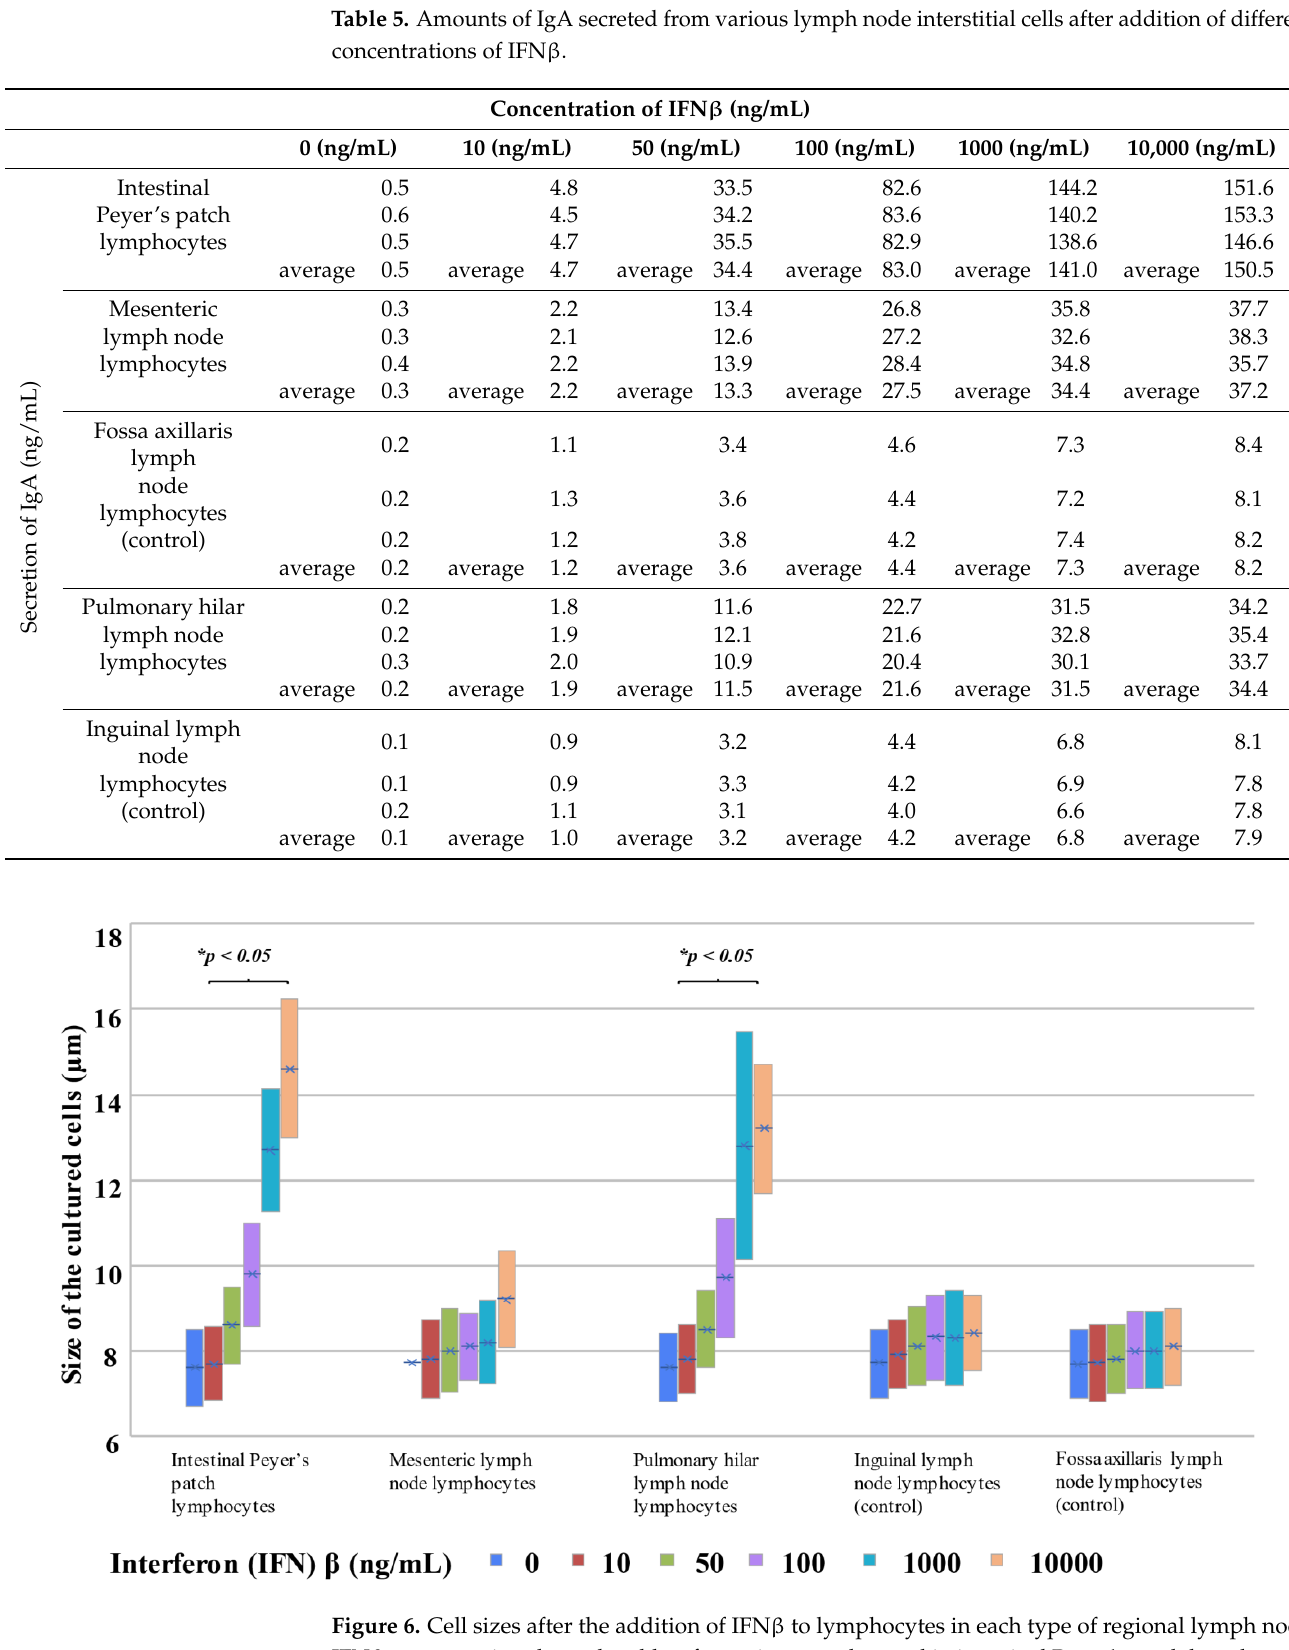
Figure 6. Cell sizes after the addition of IFN β to lymphocytes in each type of regional lymph node. IFN β concentration-dependent blast formation was observed in intestinal Peyer’s patch lymphocytes and pulmonary hilar lymph node lymphocytes.